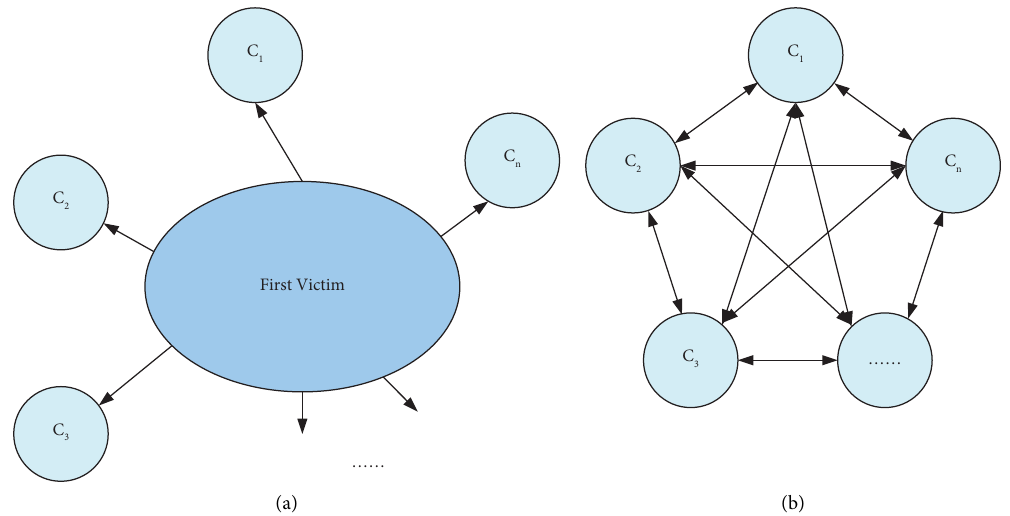
Figure 4: Financial risk contagion models: (a) a traditional one-way crisis contagion model; (b) a mesh “cross-infection” model.